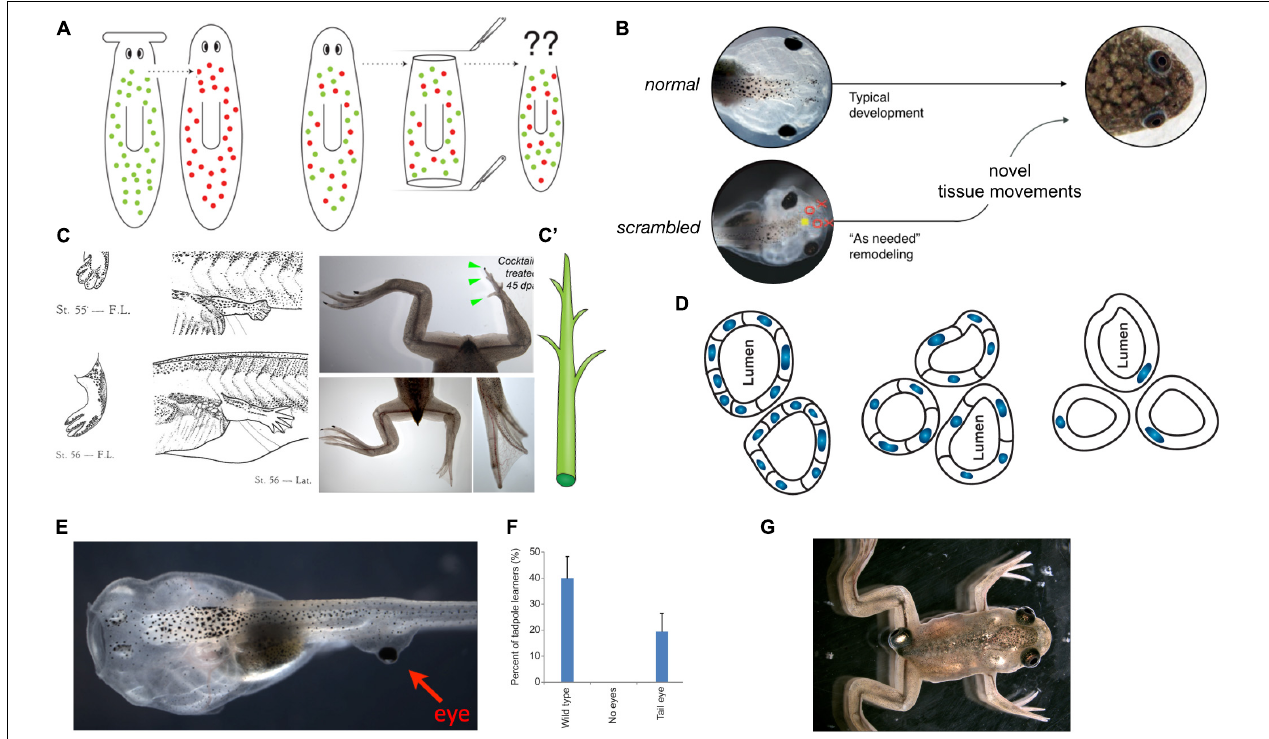
FIGURE 6 | Morphogenesis as an example of collective intelligence and plasticity. The results of complex morphogenesis are the behavior in morphospace of a collective intelligence of cells. It is essential to understand this collective intelligence because by themselves, progress in molecular genetics is insufficient. For example, despite genomic information and much pathway data on the behavior of stem cells in planarian regeneration, there are no models predicting what happens when cells from a flat-headed species are injected into a round-headed species (A) : what kind of head will they make, and will regeneration/remodeling ever stop, since the target morphology can never match what either set of cells expects? Development has the ability to overcome unpredictable perturbations to reach its goals in morphospace: tadpoles made with scrambled positions of craniofacial organs can make normal frogs (B) because the tissues will move from their abnormal starting positions in novel ways until a correct frog face is achieved (Vandenberg et al., 2012). This illustrates that the genetics seeds the development of hardware executing not an invariant set of movements but rather an error minimization (homeostatic) loop with reference to a stored anatomical setpoint (target morphology). The paths through morphospace are not unique, illustrated by the fact that when frog legs are induced to regenerate (C) , the intermediate stages are not like the developmental path of limb development (forming a paddle and using programmed cell death to separate the digits) but rather like a plant (C (cid:48) ) , in which a central core gives rise to digits growing as offshoots (green arrowheads) which nevertheless ends up being a very normal-looking frog leg (Tseng and Levin, 2013). (D) The plasticity extends across levels: when newt cells are made very large by induced polyploidy, they not only adjust the number of cells that work together to build kidney tubules with correct lumen diameter, but can call up a completely different molecular mechanism (cytoskeletal bending instead of cell:cell communication) to make a tubule consisting in cross-section of just 1 cell wrapped around itself; this illustrates intelligence of the collective, as it creatively deploys diverse lower-level modules to solve novel problems. The plasticity is not only structural but functional: when tadpoles are created to (E) have eyes on their tails (instead of in their heads), the animals can see very well (Blackiston and Levin, 2013), as revealed by their performance in visual learning paradigms (F) . Such eyes are also competent modules: they first form correctly despite their aberrant neighbors (muscle, instead of brain), then put out optic nerves which they connect to the nearby spinal cord, and later they ignore the programmed cell death of the tail, riding it backward to end up on the posterior of the frog (G) . All of this reveals the remarkable multi-scale competency of the system which can adapt to novel configurations on the fly, not requiring evolutionary timescales for adaptive functionality (and providing important buffering for mutations that make changes whose disruptive consequences are hidden from selection by the ability of modules to get their job done despite changes in their environment). Panels (A,C’,D) are courtesy of Peregrine Creative. Panel (C) is from Xenbase and Aisun Tseng. Panels (E–G) are courtesy of Douglas Blackiston. Panel (B) is used with permission from Vandenberg et al. (2012), and courtesy of Erin Switzer.